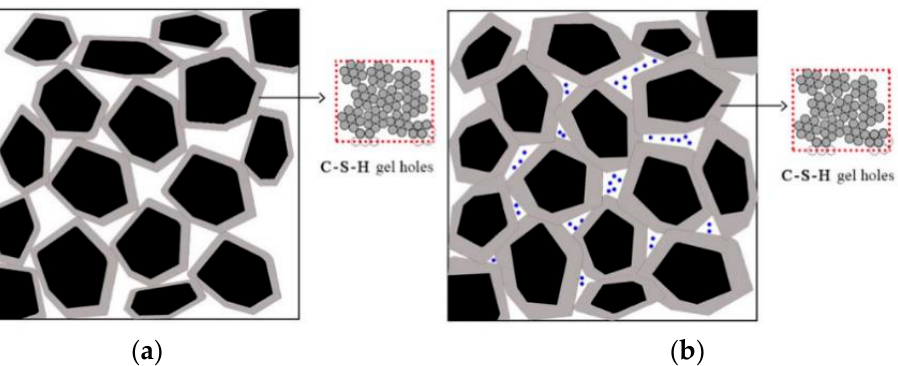
Figure 14. Mechanism of carbonation by mechanical agitation molding. ( a ) Non-invaded CO 2 ; ( b ) Invasion of CO 2 .